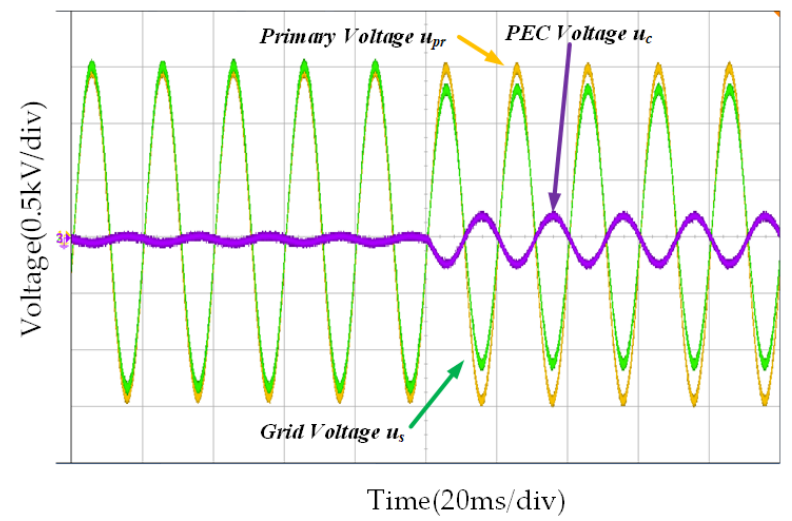
Figure 15. Waveform diagram of step-less voltage regulation with Flexible